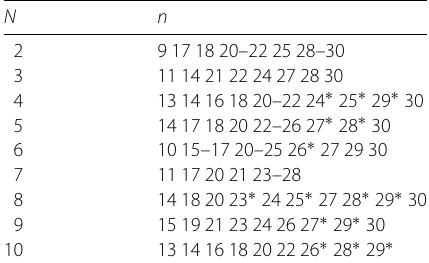
Table 7 The presence of delinquent eigenvalues of U n in the case of a block-discrete weight function N n